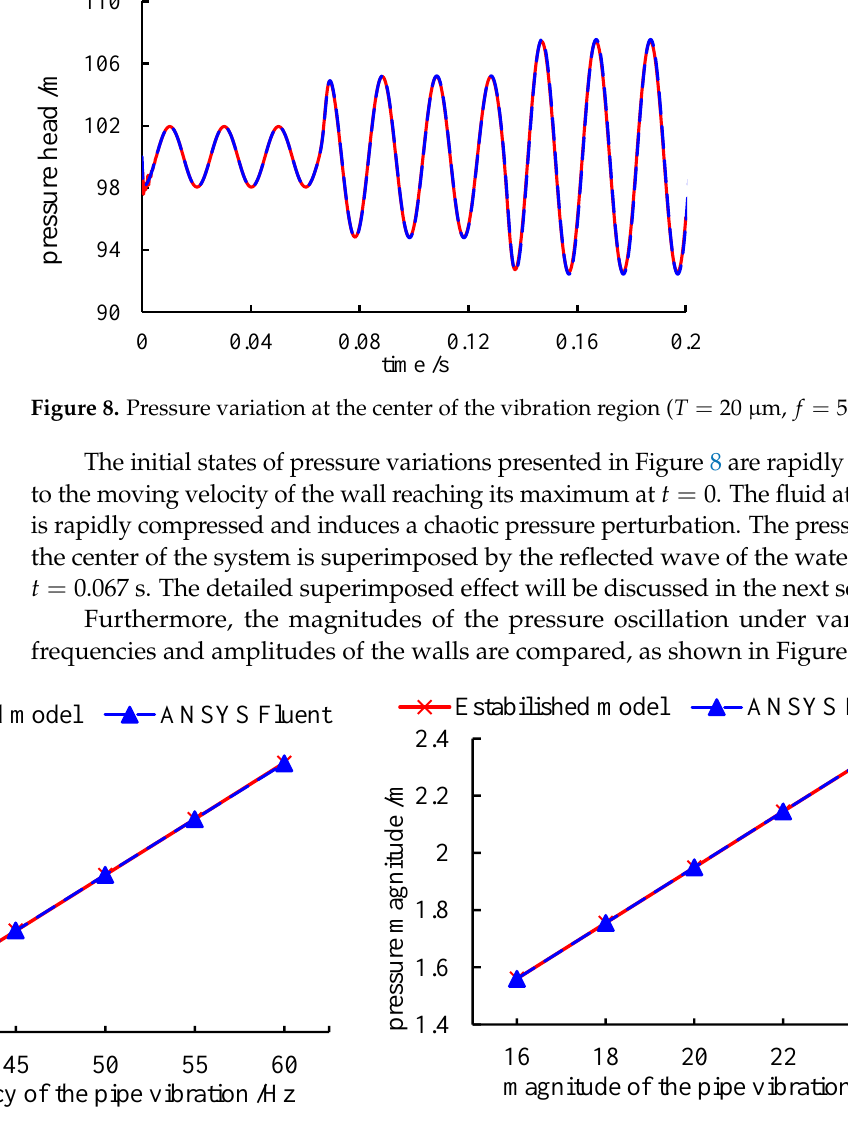
Figure 8. Pressure variation at the center of the vibration region (